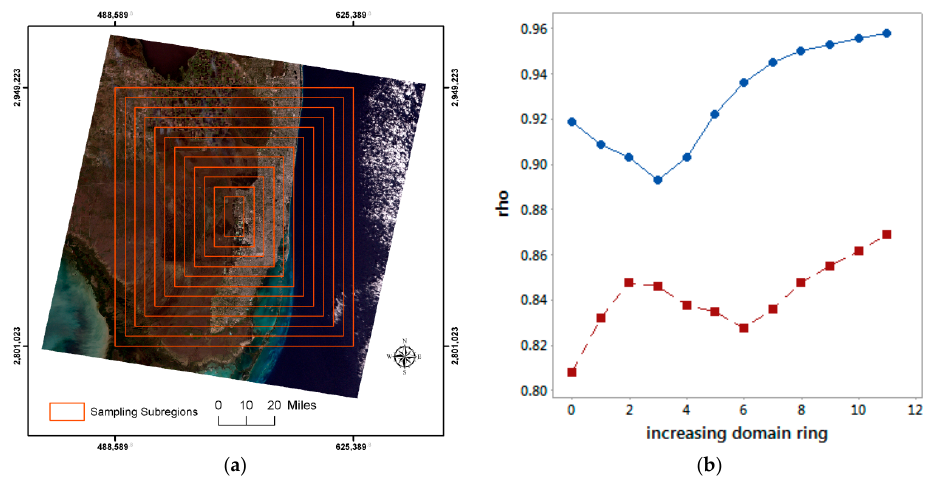
Figure 7. An increasing domain sampling design. ( a ) the increasing size landscapes; and ( b ) ˆ ρ with an increasing distance from the core region (Ring 0). Table 2. Increasing domain results.